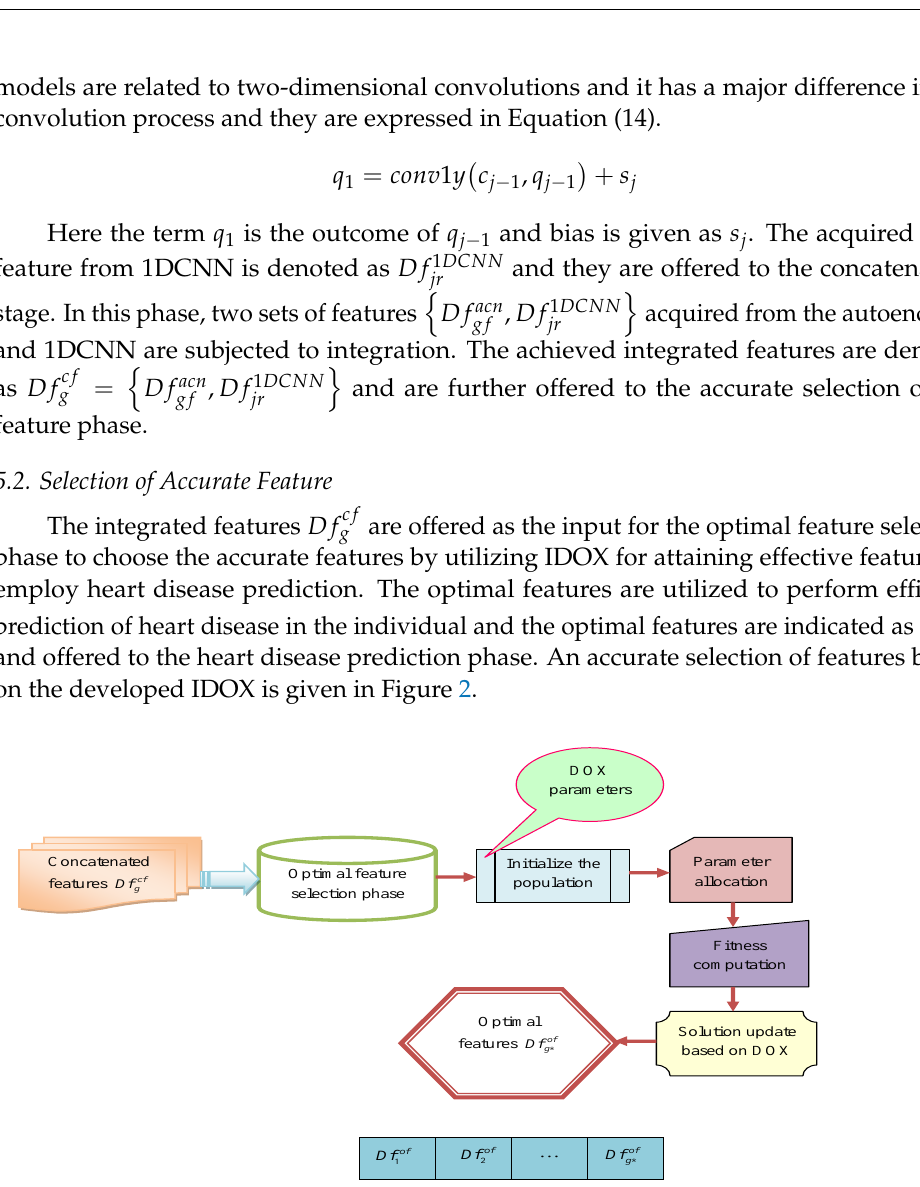
Figure 2. Optimal feature selection in the developed IDOX.